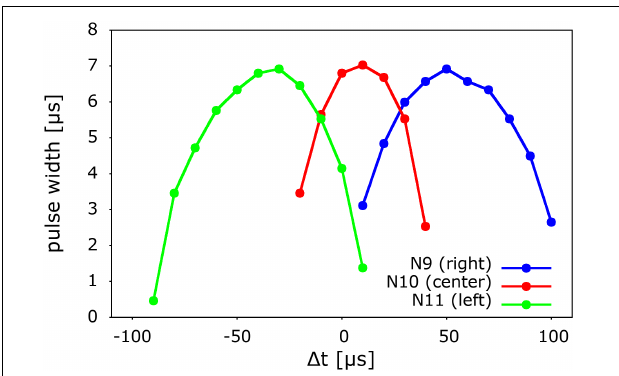
FIGURE 7 | Systematic variation of the signals of the three output neurons of the model as a function of the incoming time delay of ITD. The result of the system’s neurocomputation is coded in terms of pulse width, which is also the intensity of the spike generated by the output neurons. Note ( Figure 6A ) that the pulse width indicates the degree of overlap or coincidence of the propagating spikes. The delay (cid:49) t is defined as the time difference between the pulses at L0 and R0. A positive (cid:49) t corresponds to a pulse generated on the right side. For simplicity, the pulses were generated with a pulse generator.